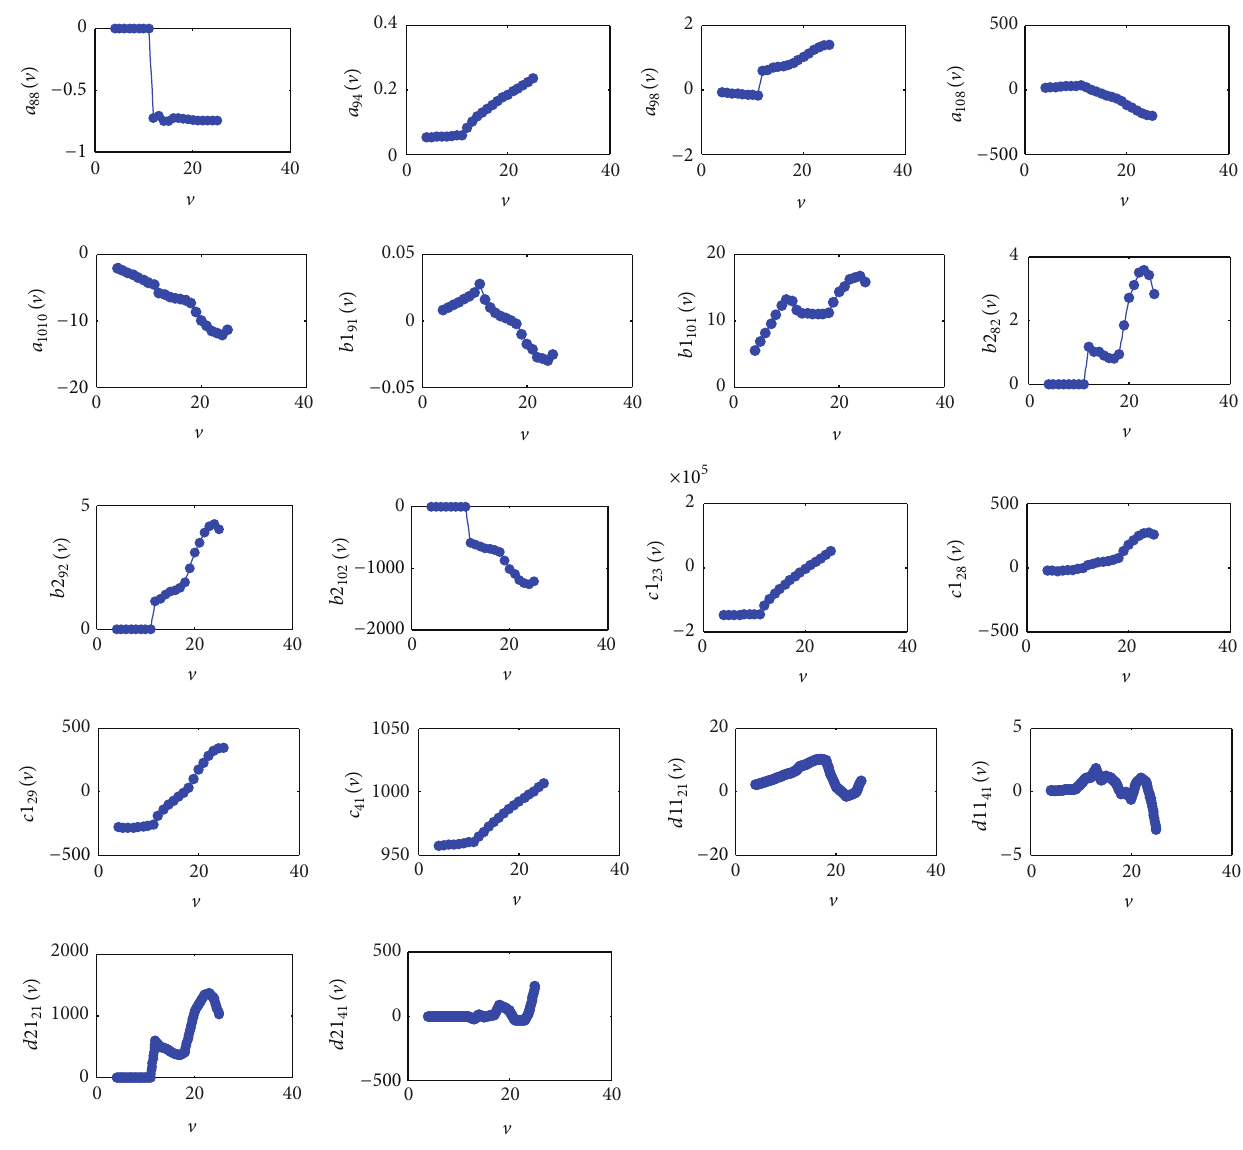
Figure 3: The values of scheduled parameters at the operation